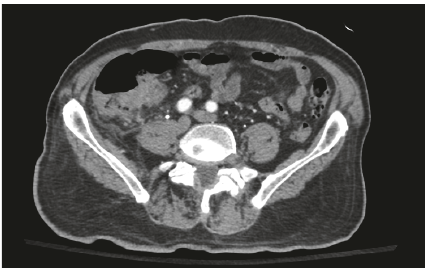
Figure 4: CT abdomen showing evidence of cecal